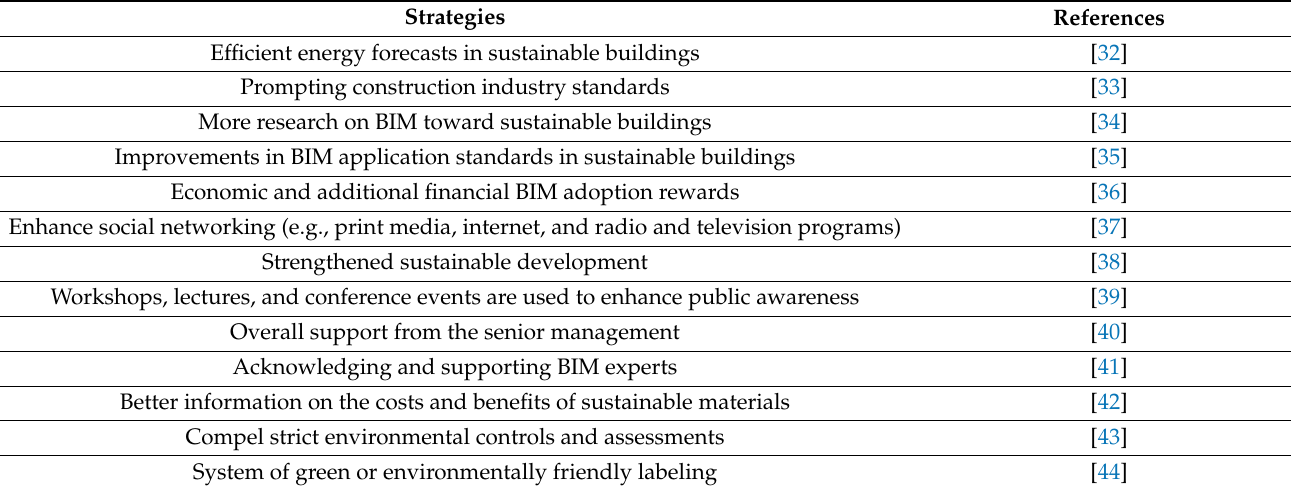
Table 1. Strategies used to adopt BIM in sustainable building projects.